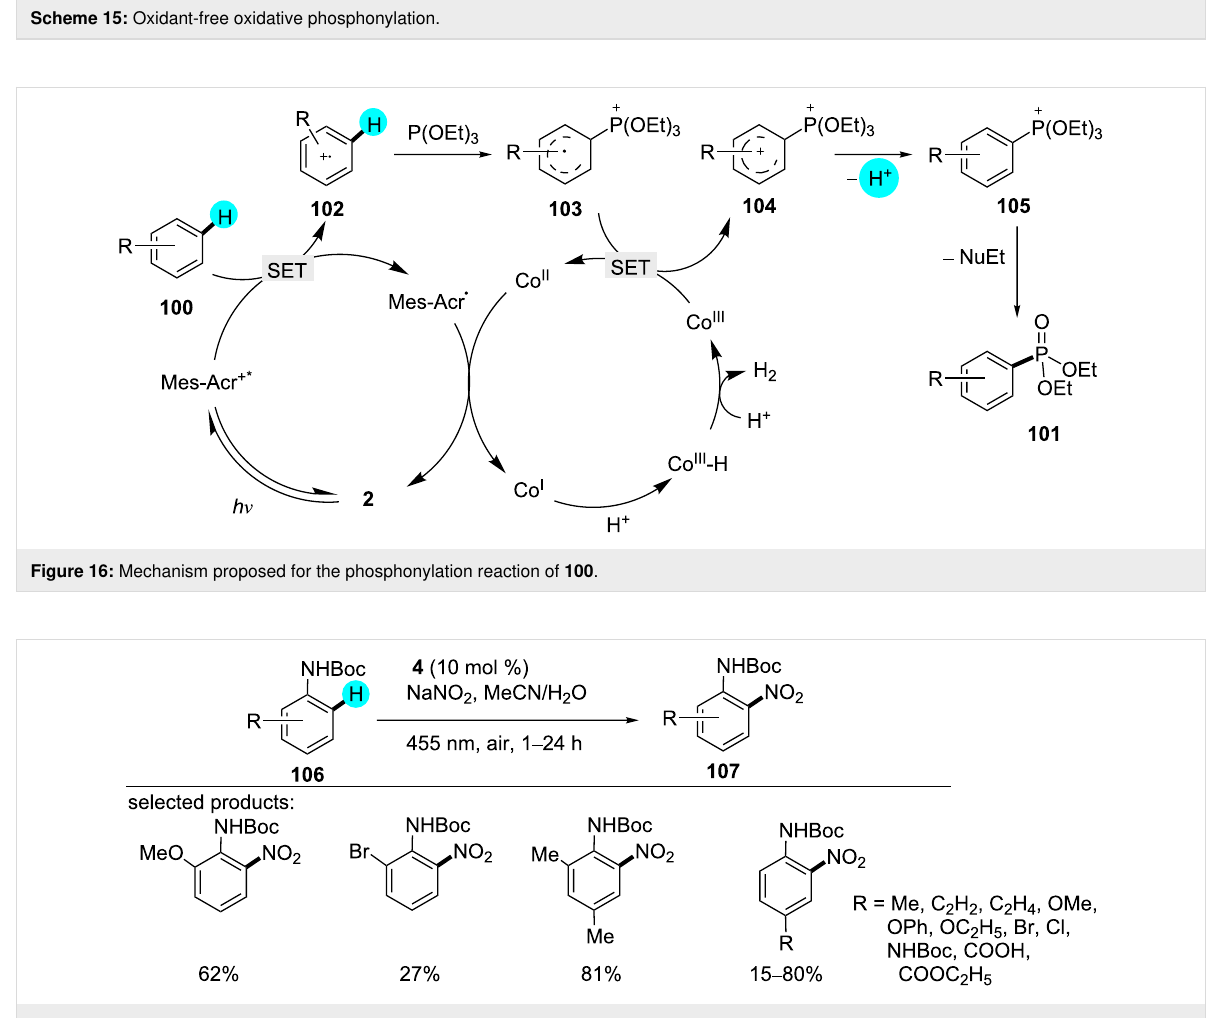
Scheme 15: Oxidant-free oxidative phosphonylation.